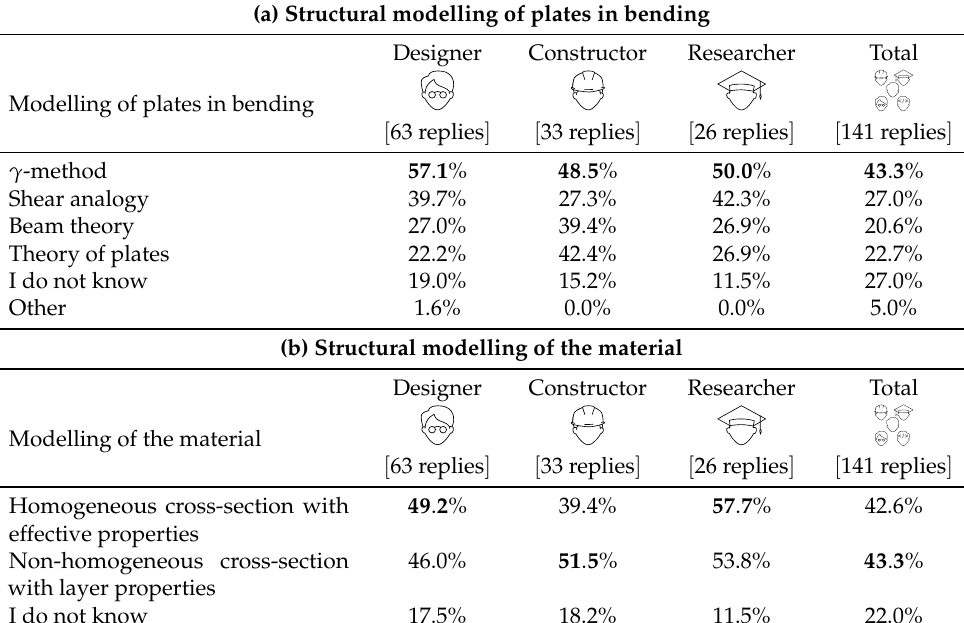
Table 4. Assumptions used for structural modelling of material and plates in bending (multiple